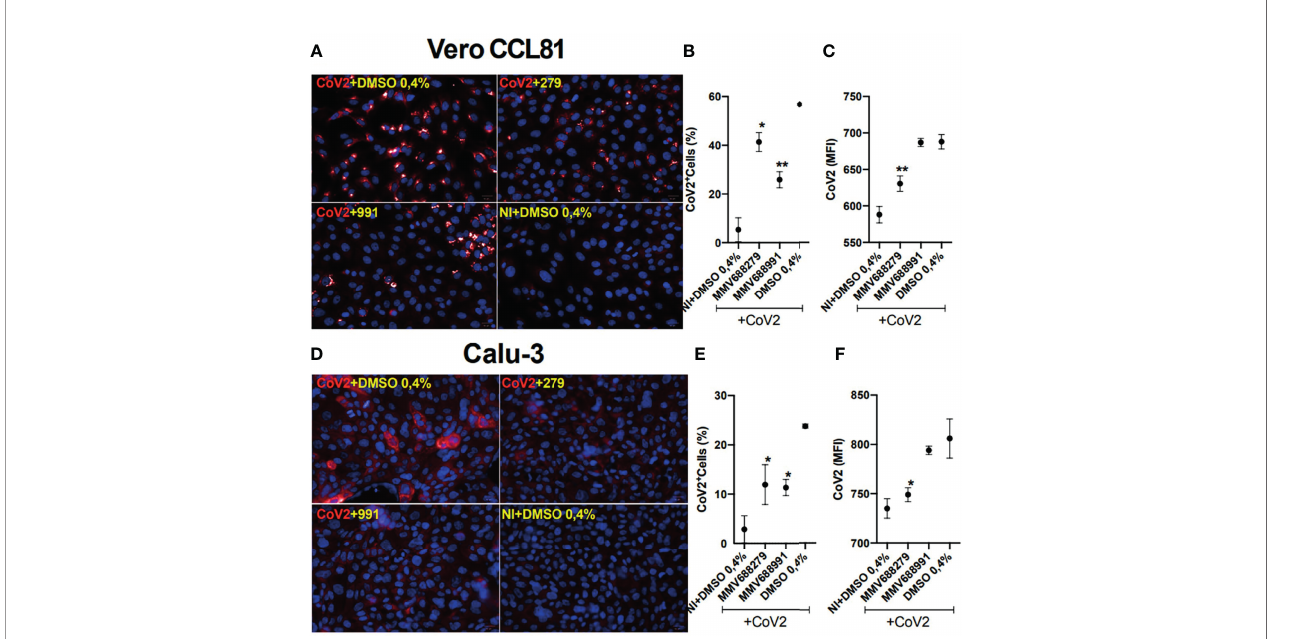
FIGURE 4 | Indirect immuno fl uorescence (IFI) detection of SARS-CoV2 infecting Vero and Calu-3 cell lines after 22 h of infection. (A, D) The representative images show the presence of Spike-1 protein stained with the Alexa647-labeled antibody (red) and con fi rm the hit activity of the compounds MMV688279 and MMV688991. Cell nuclei were stained with Hoechst (blue); bar 20µm. (B, E) Frequency of CoV2+-infected cells and the (C, F) amount of infection per cell revealed by the mean fl uorescent intensity (MFI). *p<0.05 and **p<0.01 relative to the virus-infected control group. Vehicle – DMSO